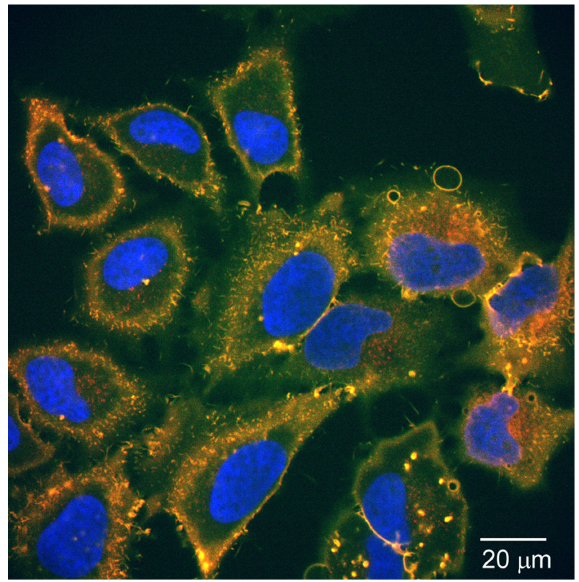
Figure 7. Confocal image of red-fluorescent 80 nm HGHGH nanoparticles in HeLa cells. Blue: nuclei, yellow: cell membranes, and red: nanoparticles. 4. Conclusions Peptides composed of Phe, Tyr, His, and Gly were designed and synthesized based on the radiation crosslinking mechanism of proteins. Thus, peptide nanoparticles, with a